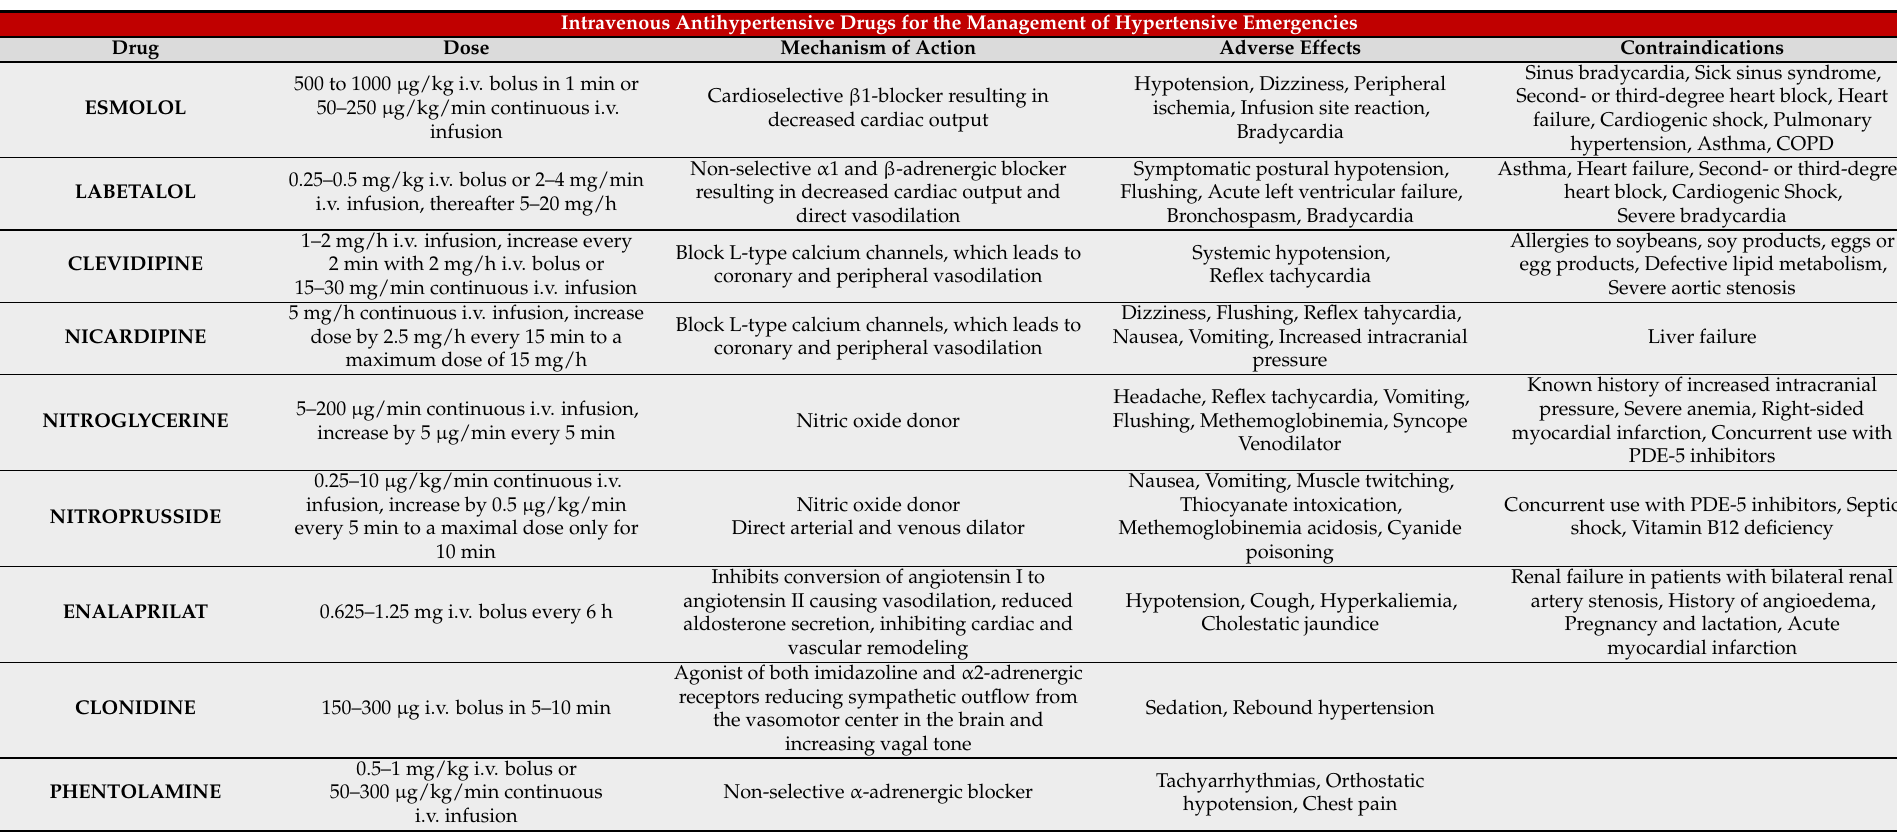
Table 1. Intravenous antihypertensive drugs for the management of hypertensive emergencies. I.v.—intravenous; Kg—kilograms; COPD—Chronic obstructive pulmonary disease; PDE-5 inhibitors—Phosphodiesterase 5